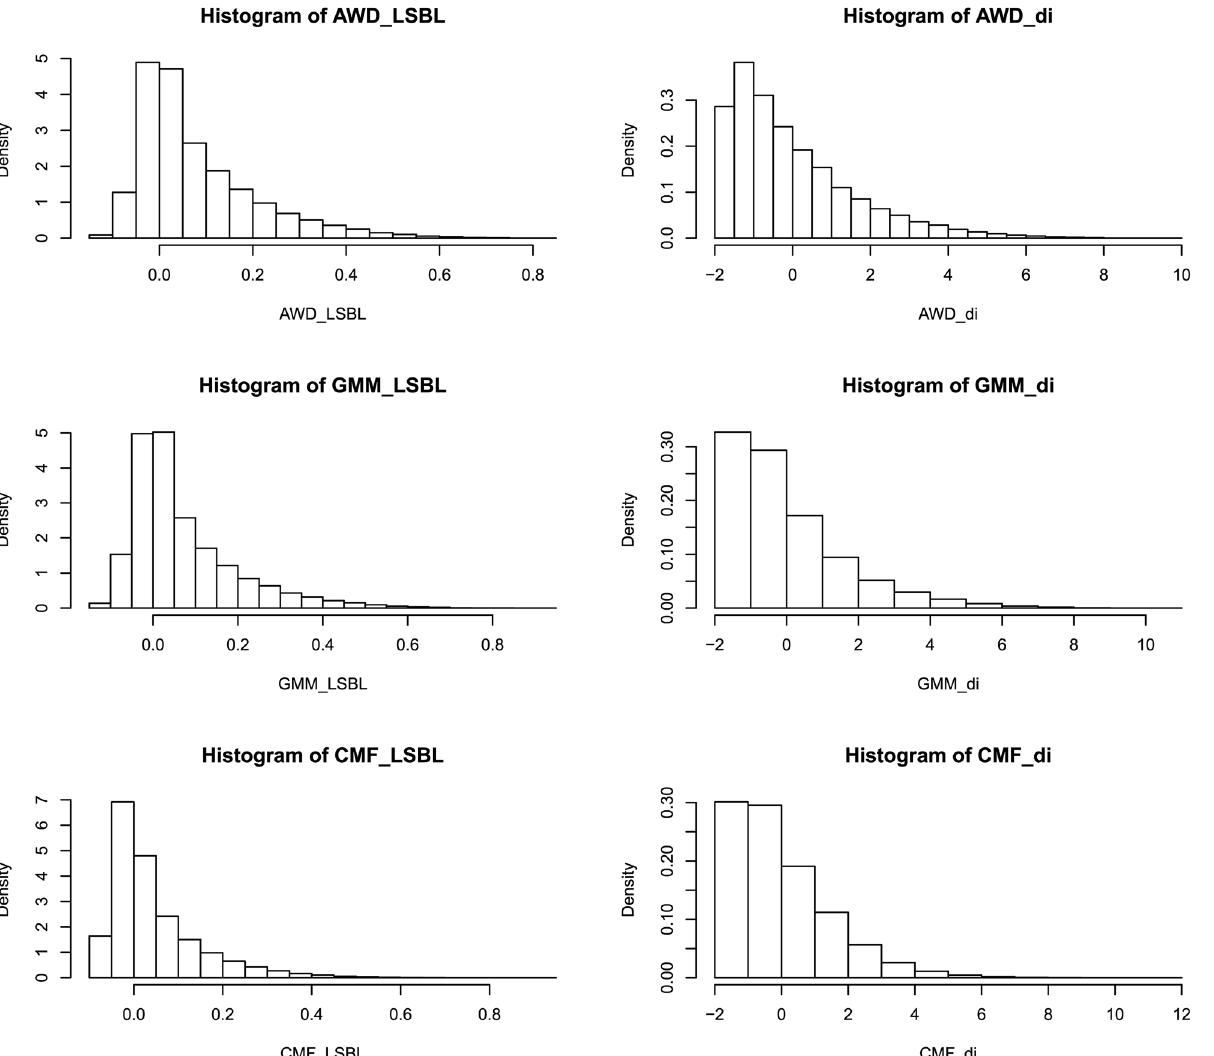
Fig 3. Histogram of the LSBL and d i statistics distribution for each